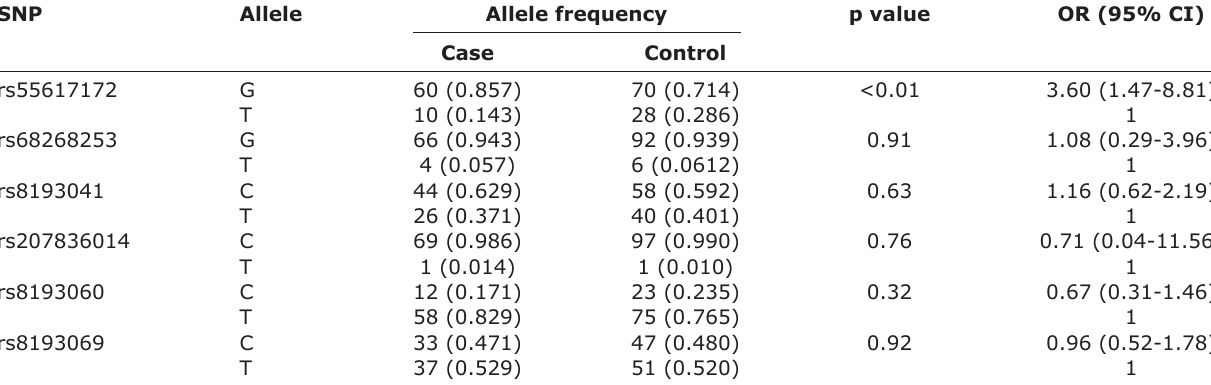
Table-2: Allelic frequency distribution of TLR genes and their association with bTB. SNP Allele